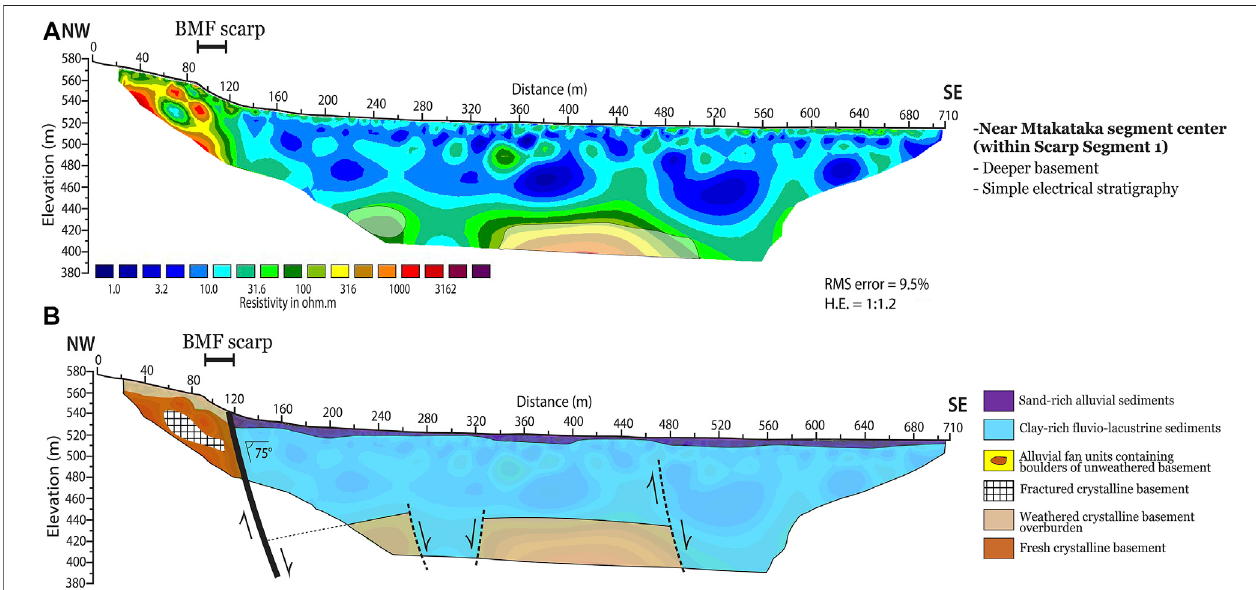
FIGURE 7 | (A) Inverse model of the ERT Pro fi le 1 acquired near the center of Scarp Segment 1 (Ngodzi) in the north-western section of the Bilila-Mtakataka Fault (BMF) ( Figure 2C ). The white transparent polygons are areas of low model sensitivity ( Supplementary Figure S1A ). (B) Geologic model and interpretation of the resistivity model.